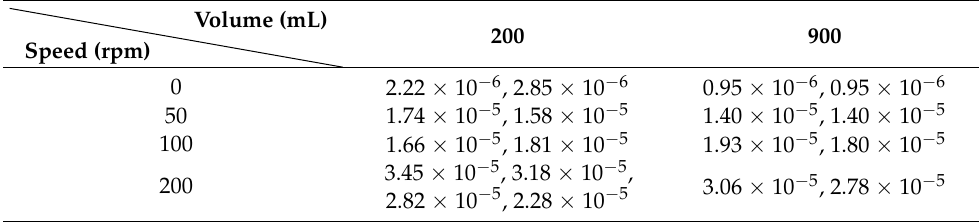
Table 2. Mass-transfer coefficients (m s − 1 ) for 0.3 g benzoic acid tablets dissolved in deionized water (USP dissolution apparatus